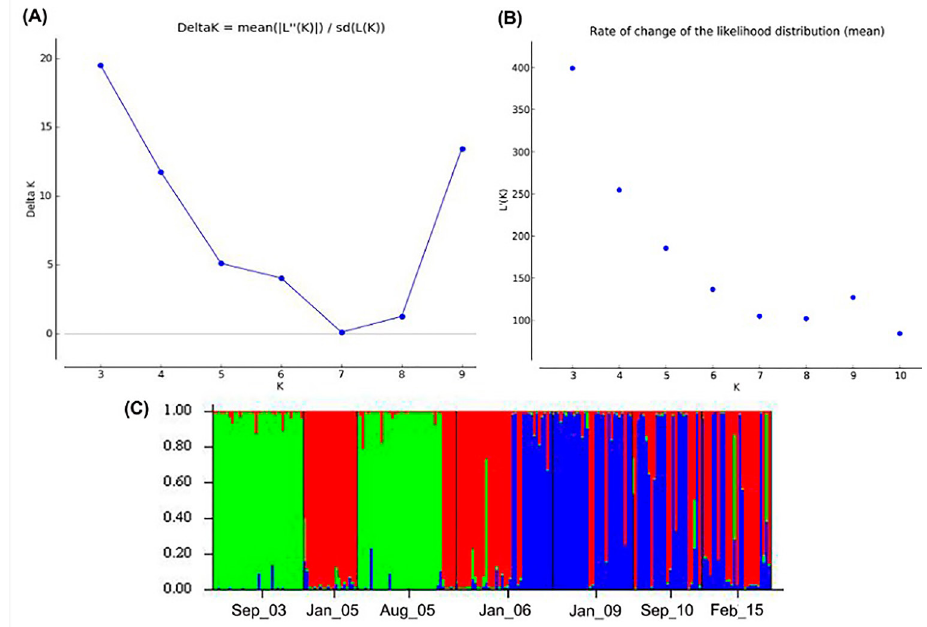
FIGURE 2 | Graph of the Bayesian analysis of population structure of microsatellites for Prochilodus lineatus . A. Delta(k) showing the highest value in a population structure of K = 3; B. The estimated mean log-likelihoods [ln(PrK)]; C. Structure bar plot. Black lines separate the different sampled populations based on temporal collection.